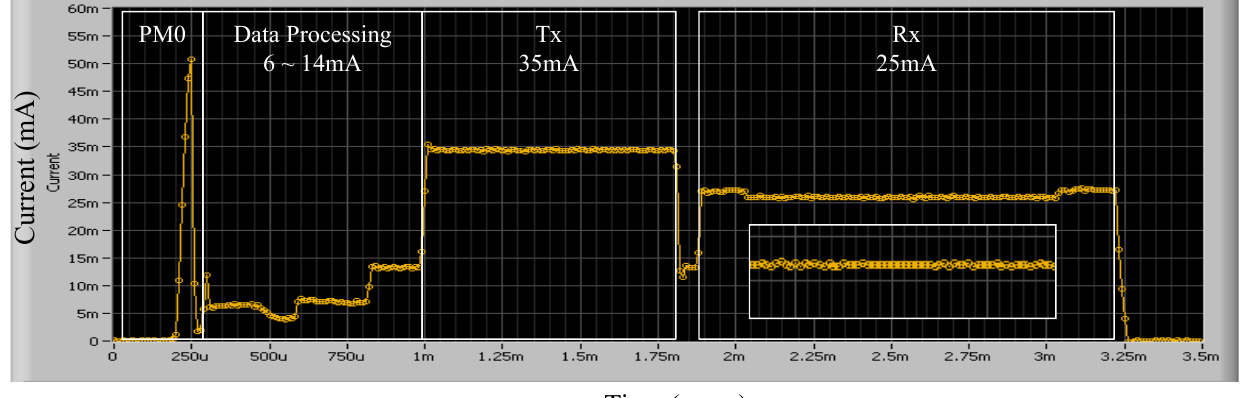
Figure 12. Measurement of current consumed by μ COSII-based system during transmission of a